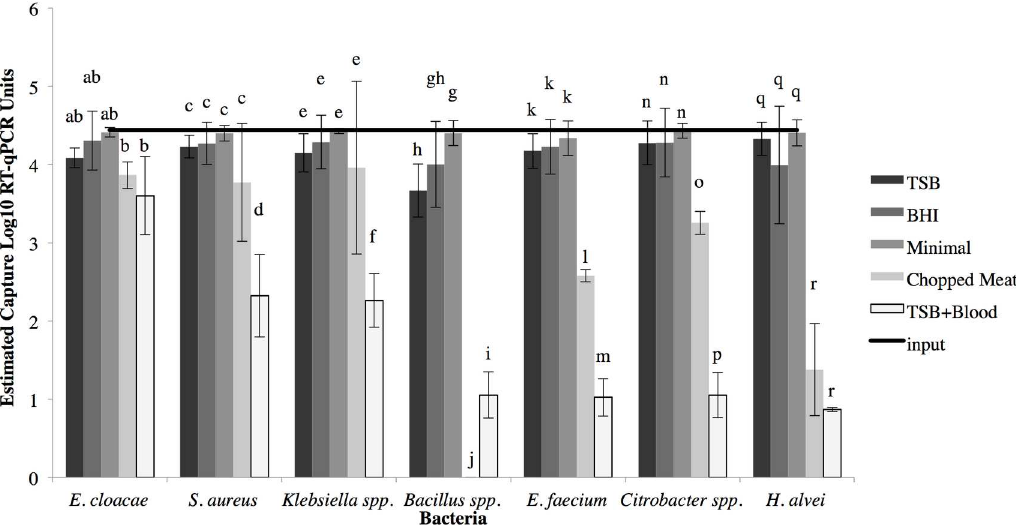
Fig 2. Binding efficiency of the GII.4 Sydney 2012 when bacterial strains were grown in different media. The line indicatesthe total virus input. Data are expressedas mean log 10 concentration of bacteria bound ± the standard deviation(in RT-qPCRU) (bars) and percent bindingefficiency as determinedby loss-to-supernatant ((total input virus- supernatant virus)/total input virus) (numerical). Letters indicate statistically significantdifferences (p < 0.05)between the amount of virus bound for each bacterial strain cultured using different growth media. Different letters within the same bacteria indicatestatistical difference. Statistical differencesin bindingbetweendifferent bacteria was not tested. Data represent averagesand standard deviations of the assays performed in